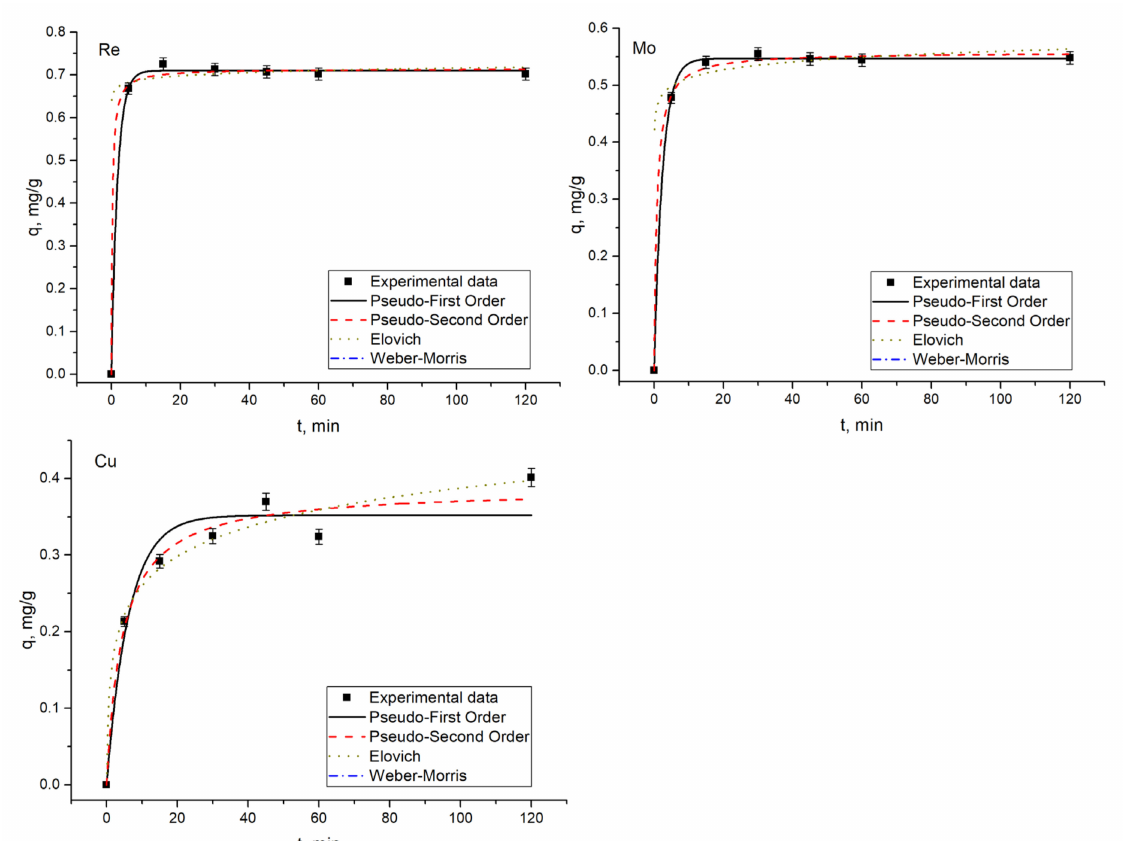
Figure 7. Kinetics of rhenium and copper biosorption on yeast